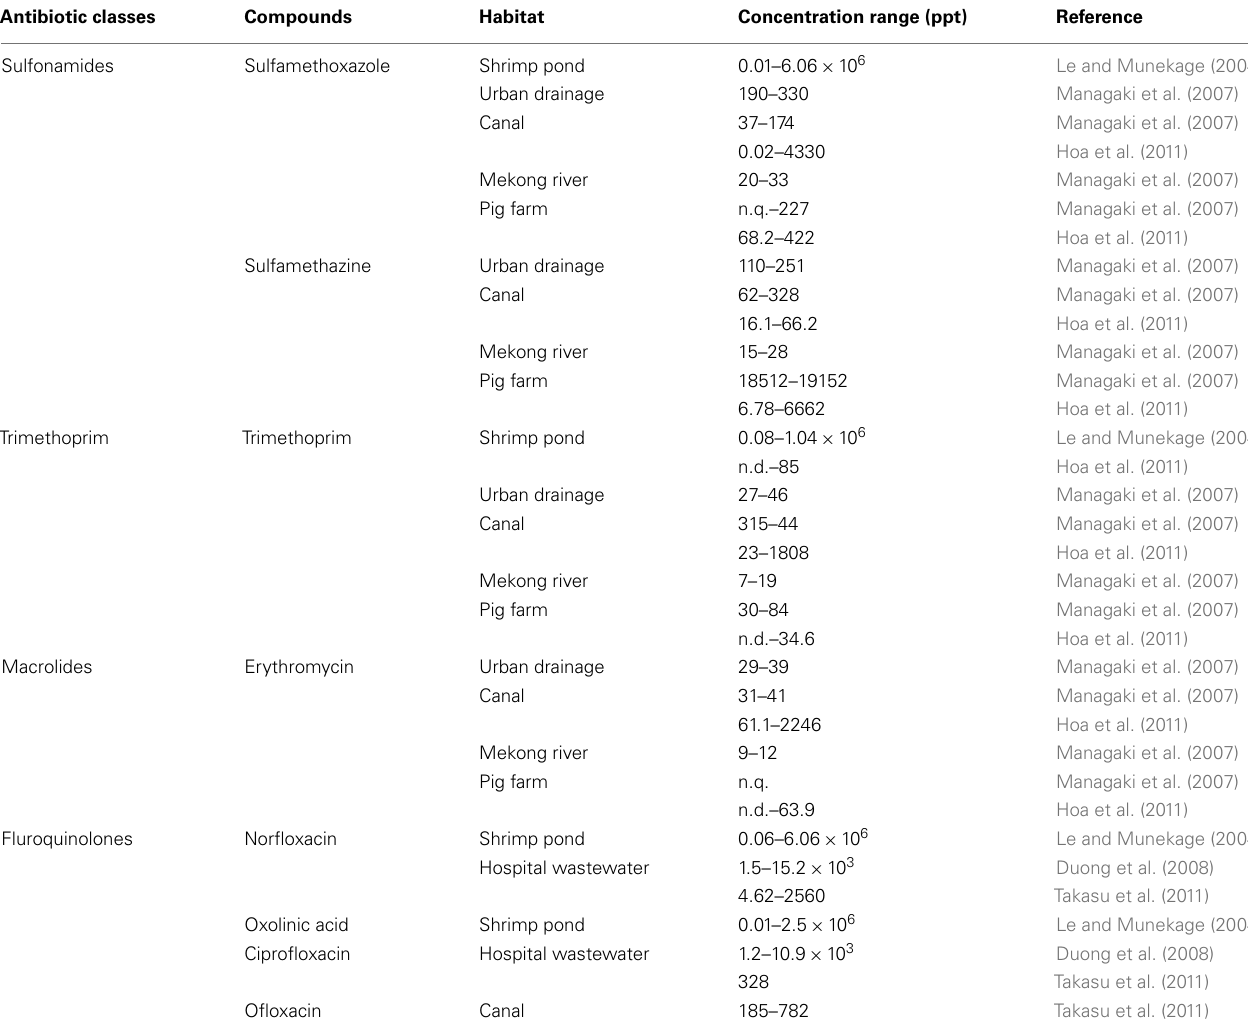
Table 1 |Antibiotics detected in aquatic environments of Indochina